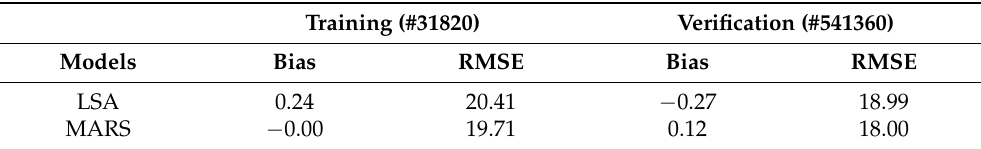
Table A3. Bias and root mean square error of LSA-SAF and MARS for the training and verification samples (#) in clear-sky conditions. Units are in W · m − 2 .